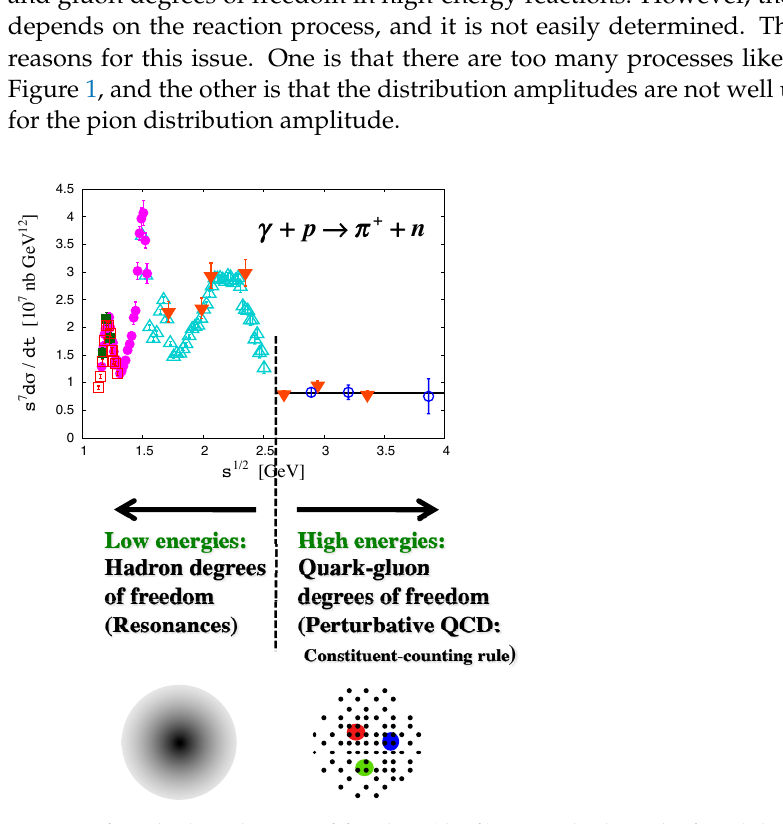
Figure 2. from hadron degrees-of-freedom (d.o.f.) to quark-gluon d.o.f. and the constituent counting rule in γ + p → π + + n reaction. Top: Cross-section measurements as a function of the center- √ s : the open red squares show the data by Fischer et al. (1970) [23], the solid of-mass energy, black squares show the data by Clifft et al. (1974) [24], the the solid pink circles show the data by Fujii et al. (1977) [25], the open turquoise triangles show the data by CLAS Collaboration (2009) [26], the inverse red triangles show the data by Jeff. Lab. Hall A and E94-104 Collaborations (2005) [27], the open blue circles show the data by Anderson et al. (1976) [28]; see also [29]. Bottom : D.o.f. picture. The grey circle shadowed indicates a proton, the colored circles indicate different quarks, and the dots indicate gluons and sea quarks. “QCD” stays for quantum